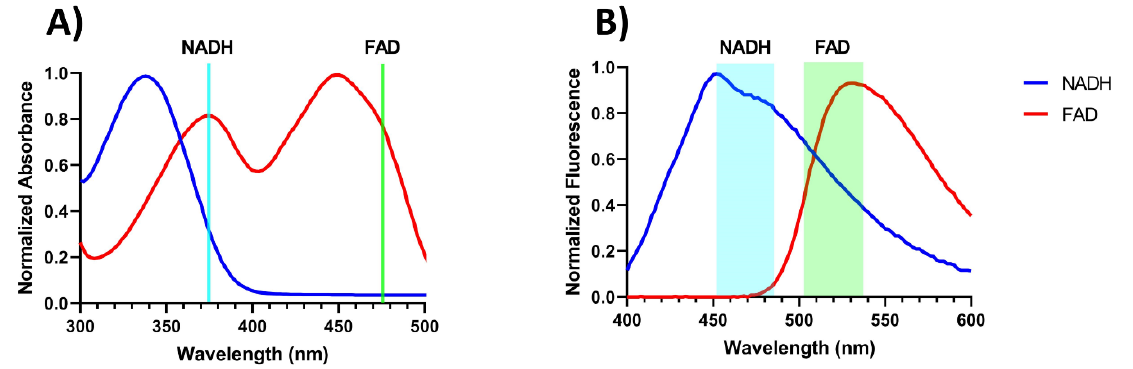
Figure 2. Absorption and emission spectra of NADH and FAD solutions. ( A ) Normalized absorption spectrum of NADH (blue) and FAD (red). The cyan and green lines represent the excitation wave- length used to excite the NADH and FAD: ( B ) Normalized emission spectrum NADH (blue) and FAD (red), with the cyan and green boxes representing the bandpass window of the endoscope for NADH and FAD,